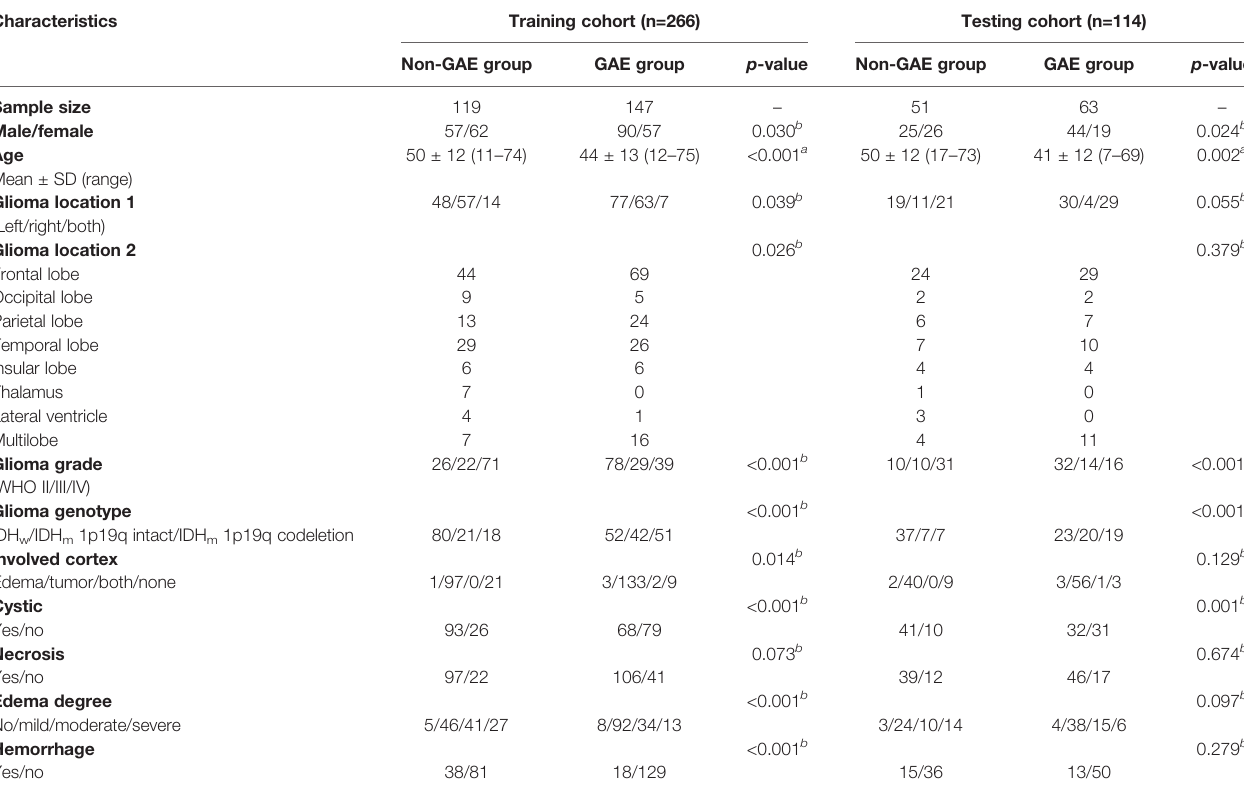
TABLE 1 | Patients ’ clinical and radiological characteristics by univariate analyses for glioma-associated epilepsy grouping.